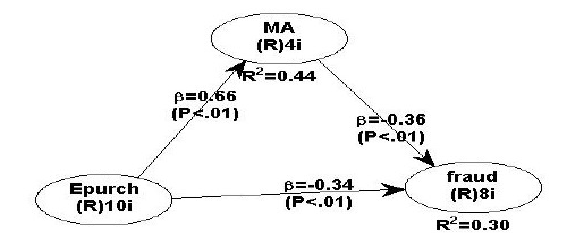
Fig. 1. Output of WarpPLS 7.0 - Full Model